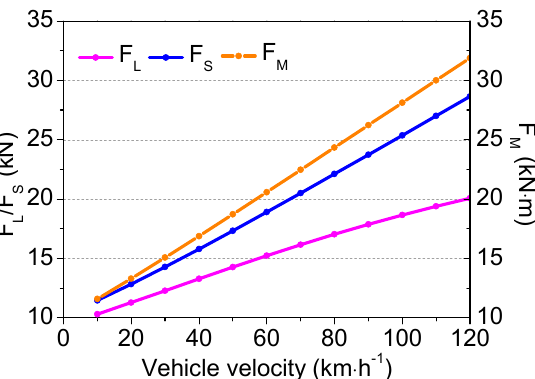
Figure 11. As in Figure 9 but the impact of vehicle velocity.